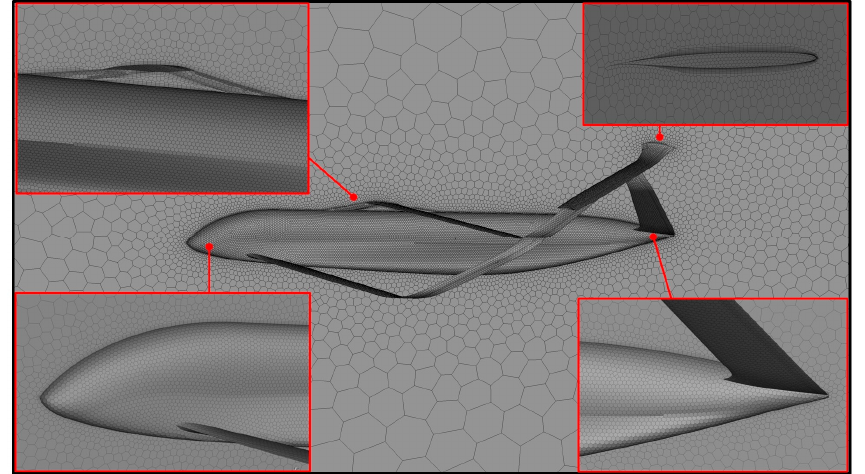
Figure 12. BWA/SL aircraft: Unstructured mesh used for the aerodynamic (CFD) computations.